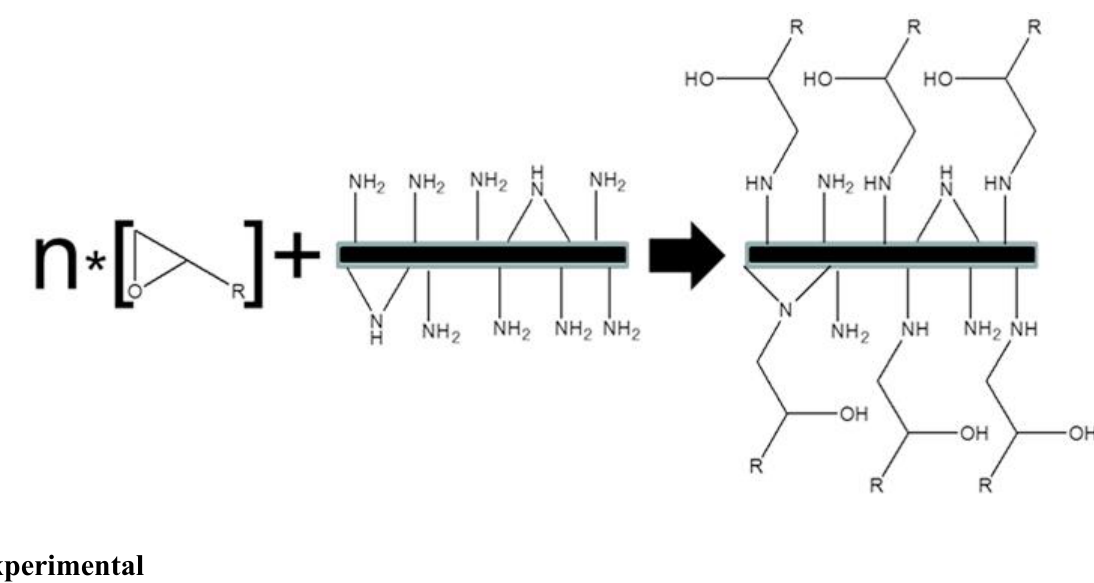
Figure 1. Schematic illustration of the interfacial reaction between epoxy and allylamine plasma coated MWCNTs after